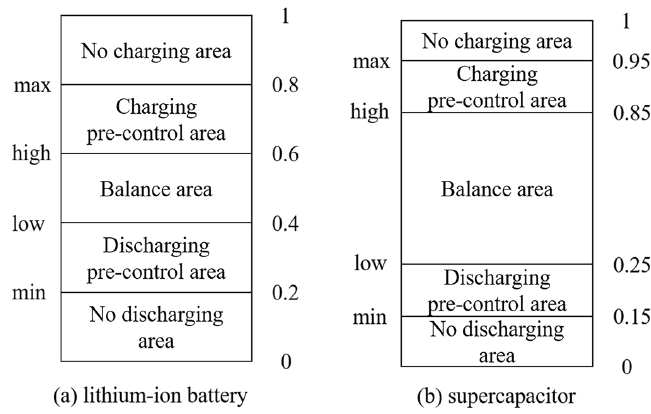
Figure 9. Charging/discharging regions.